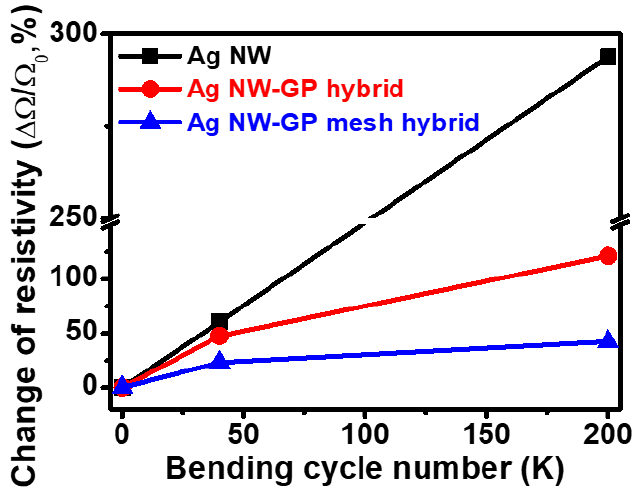
Figure 6. Cyclic bending fatigue test measured at 1R for 200k cycles for conductors (Ag NW, Ag NW- pristine GP hybrid (Ag NW-GP hybrid) and Ag NW-irregularly patterned GP mesh hybrid (Ag NW-GP mesh hybrid).